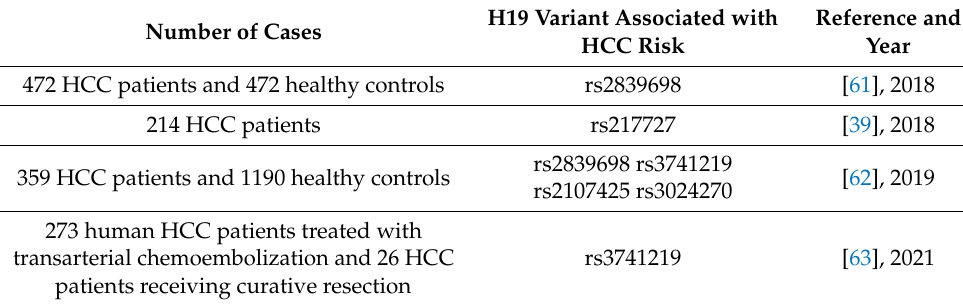
Table 2. H19 polymorphisms and their association with HCC